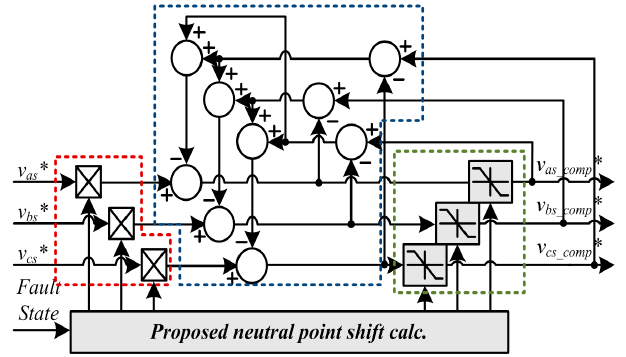
Figure 12. Proposed fault-tolerance control block diagram.